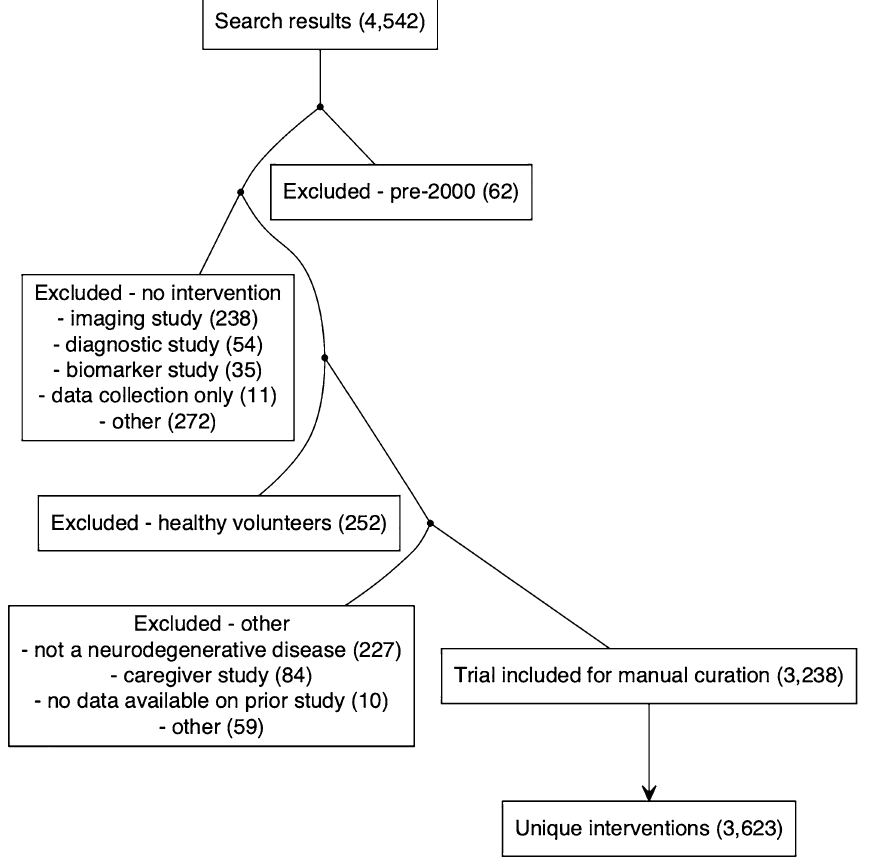
Figure 1. Flowchart of trial inclusion and curation. Trials returned by our search strategy were sequentially excluded based on launch year, lack of therapeutic intervention, patient population, or other. See Methods for